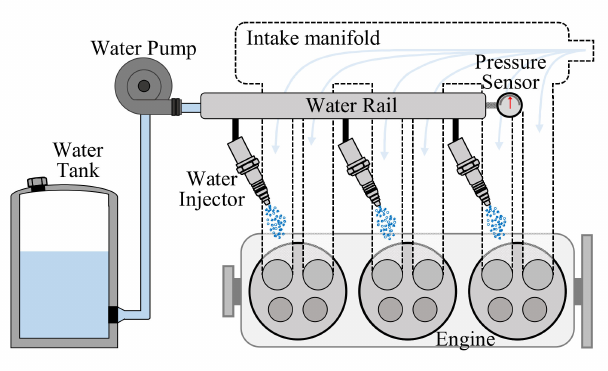
Figure 1. Schematic layout of Port Water Injection system.